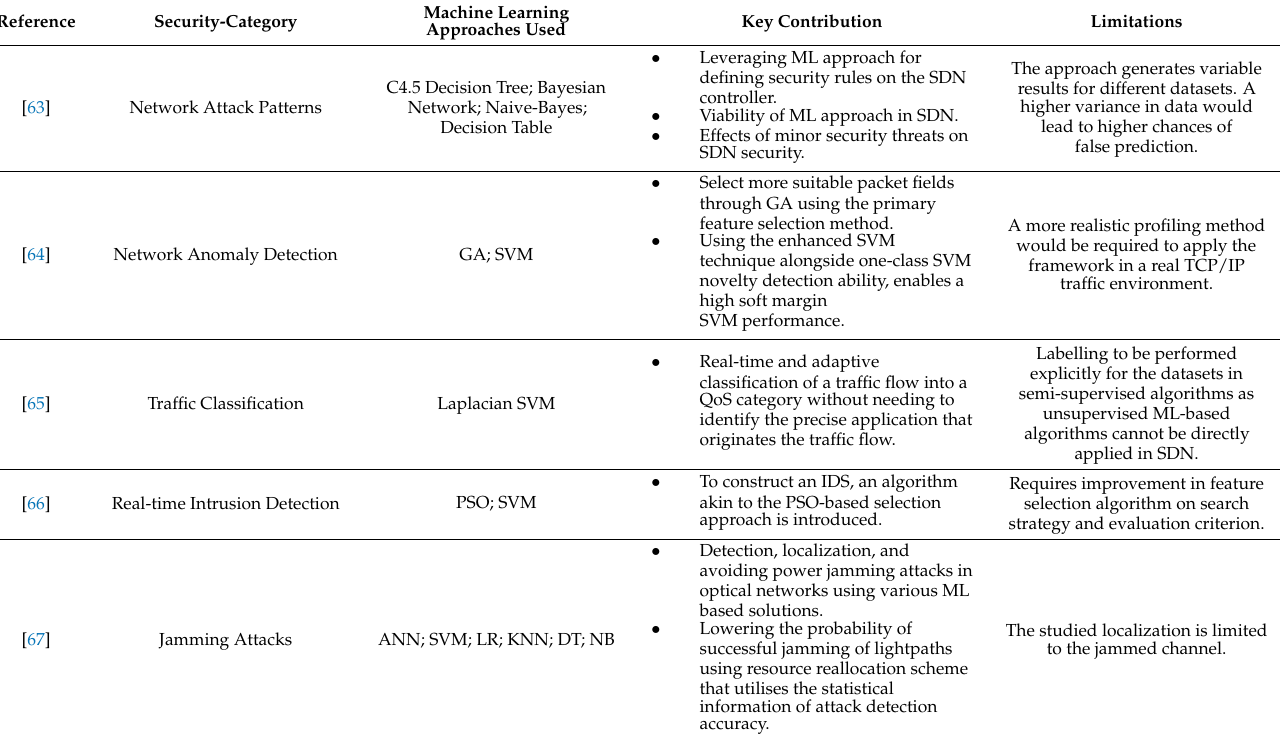
Table 2. A summary of works on machine learning techniques for electronic information